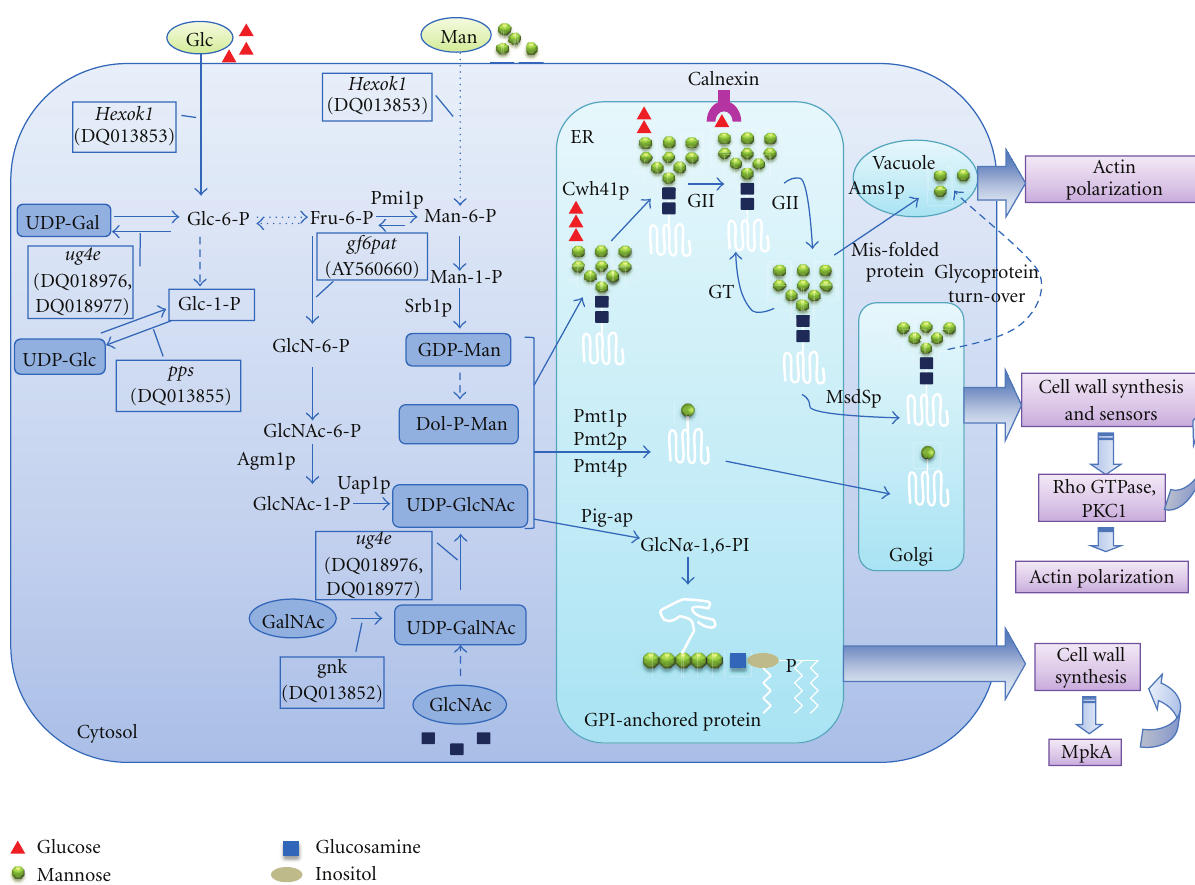
Figure 7: Pathways and functions of protein glycosylation in A. fumigatus . In A. fumigatus , the activation of mannose initiates from formation of mannose 6-phosphate (Man-6-P), which occurs by one of two routes: direct phosphorylation of mannose by hexokinase or interconversion from fructose 6-phosphate (Fru-6-P), the latter pathway requires three enzymes: phosphomannose isomerase (PMI), phosphomannomutase (PMM), and GDP-mannose pyrophosphorylase (GMPP). Pmi1p (AFUA 1G13280), Sec53p (AFUA 6G06580), and Srb1p (AFUA 6G07620) have been annotated as PMI, PMM, and GMPP, respectively. Functional analyses of Pmi1p and Srb1 imply that mannose activation is specifically crucial for the synthesis and organization of the cell wall and thus essential for survival of A. fumigatus . The N-glycosylation is initiated by transfer of Dol-PP-linked Glc 3 Man 9 GlcNAc 2 to an asparagine residue within an N-X-T/S consensus sequence of a nascent peptide, which is catalyzed by Stt3p (AFUA 8G04430), a putative catalytic subunit of the oligosaccharyltransferase (OST) complex. Subsequently, the N-glycan is processed sequentially in the ER and Golgi. N-Glycan processing is initiated by the removal of the glucose residues catalyzed by ER glucosidase I Cwh41p (AFUA 6G04210) and glucosidase II (AFUA 5G03500) to the monoglucosylated form, which is bound by calnexin (AFUA 4G12850). For many glycoproteins, the interaction with calnexin slows down the rate of folding but increases e ffi ciency. GII-catalyzed removal of the third glucose residue follows the dissociation of folding substrates from calnexin and is required for the release of properly folded proteins from the ER and transport to the Golgi. When correct folding is not achieved, the folding sensor peptide:glucosyltransferase (GT) (AFUA 2G02360) adds back a terminal glucose to promote reassociation of nonnative polypeptides released from calnexin, thus prolonging their retention in the ER folding environment. Cycles of de-/reglucosylation might be protracted until the polypeptide released from calnexin fulfills quality control